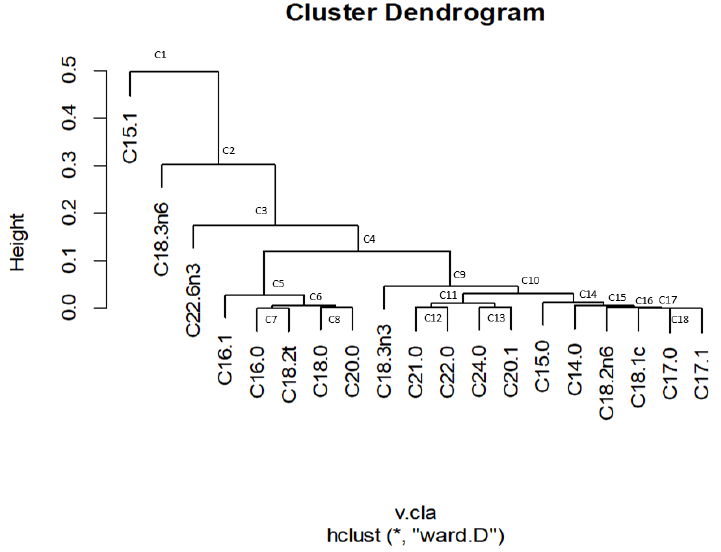
Figure 3. Clustering analysis of FAs (*, Q-Mode), using Ward’s method. This segregation was also one of the criteria used for selecting the FAs ’ order in the SBP of the original data set.